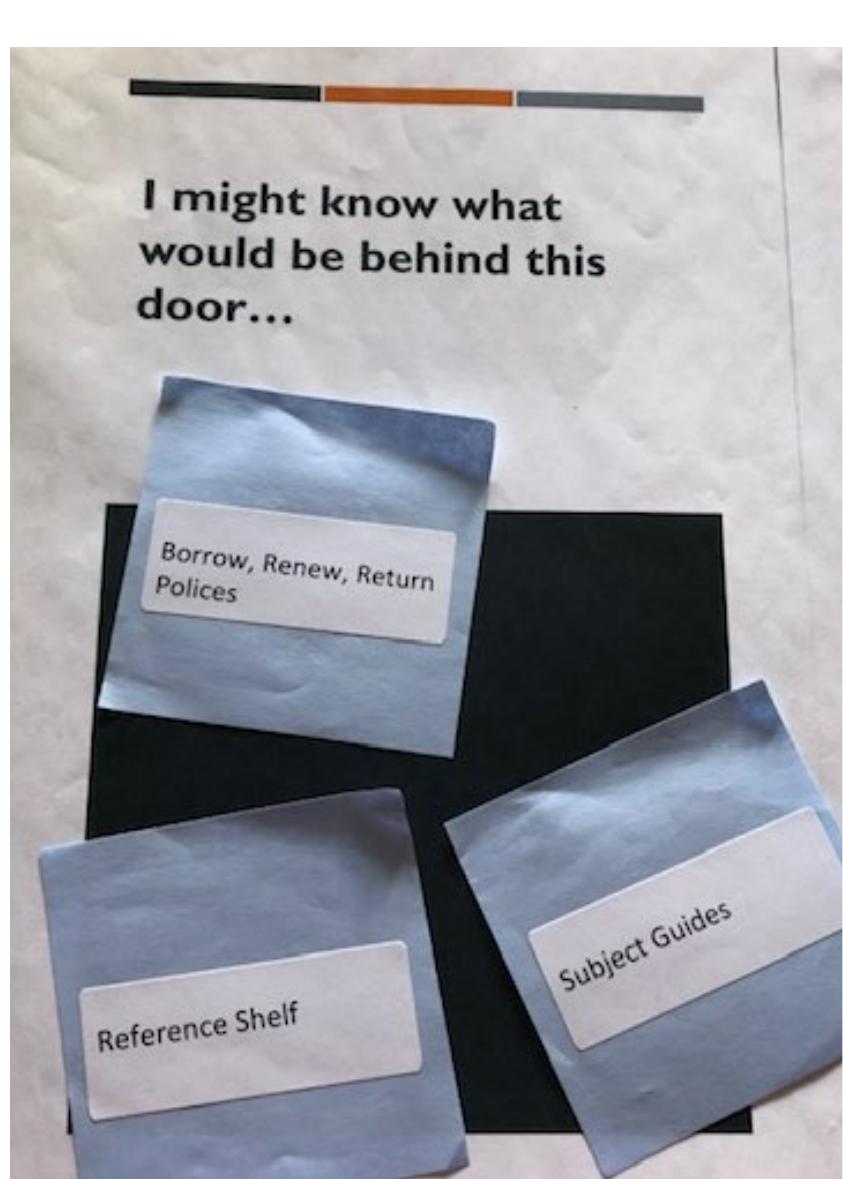
Photo of student response to card-sort test example While no individual data was collected, it was possible to correlate a participant’s definitions with their comfort level at clicking on the “RE” word links. The results of all fourteen terms are displayed in Figure 2. Of the four “RE” words, Course Reserves and Reference Shelf had the greatest return of “No Idea”